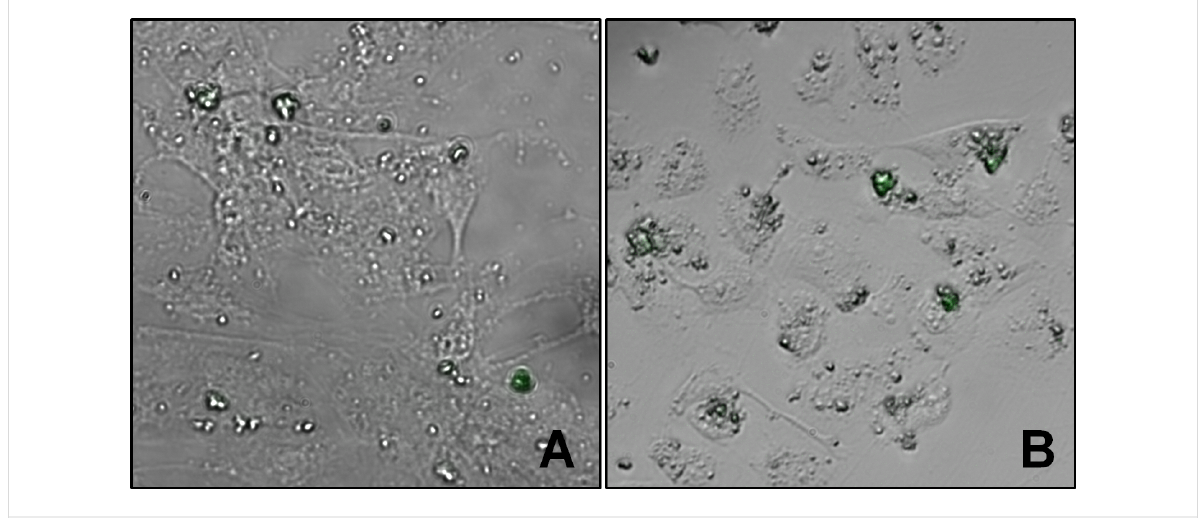
Figure 5: Representative merged bright field and fluorescent microscopy images of hMSCs (A) and PC3 cells (B) after 32 h exposure to 10 µg/mL ND-DGEA conjugates. After treatment, cells were washed three times with PBS to remove unattached or internalized ND-DGEA and imaged using fluorescently labeled DGEA peptide for visualization. In comparison to hMSCs, interaction of ND-DGEA with PC3 was much greater. Green repre- sents fluorescence due to DGEA peptide. All images are shown with 40× magnification.